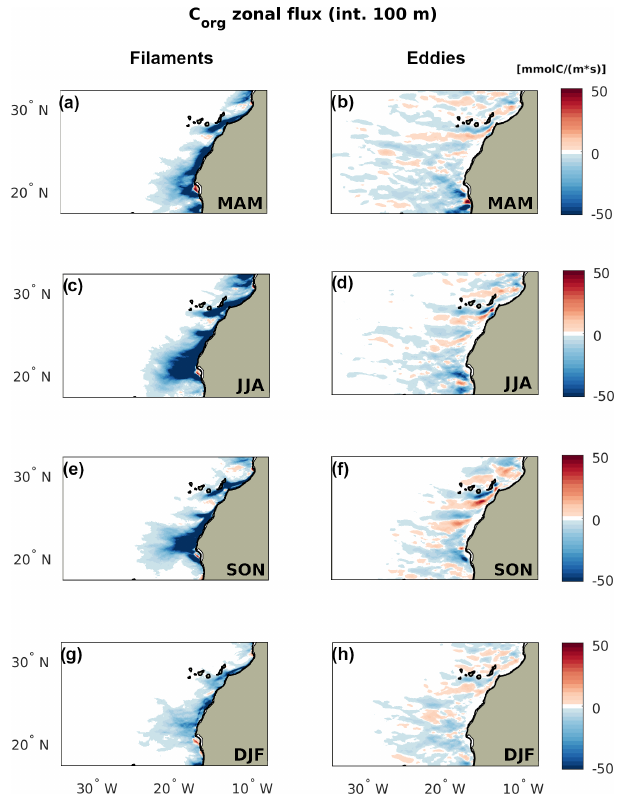
Figure 3. Seasonality of the eddy (cyclonic + anticyclonic) and fil- ament offshore transport of C org . The first column represents the filament transport. The second column represents the eddy trans- port. The flux is integrated over the top 100m depth. Subpanels: (a) and (b) spring (MAM), (c) and (d) summer (JJA), (e) and (f) fall (SON), and (g) and (h) winter (DJF).